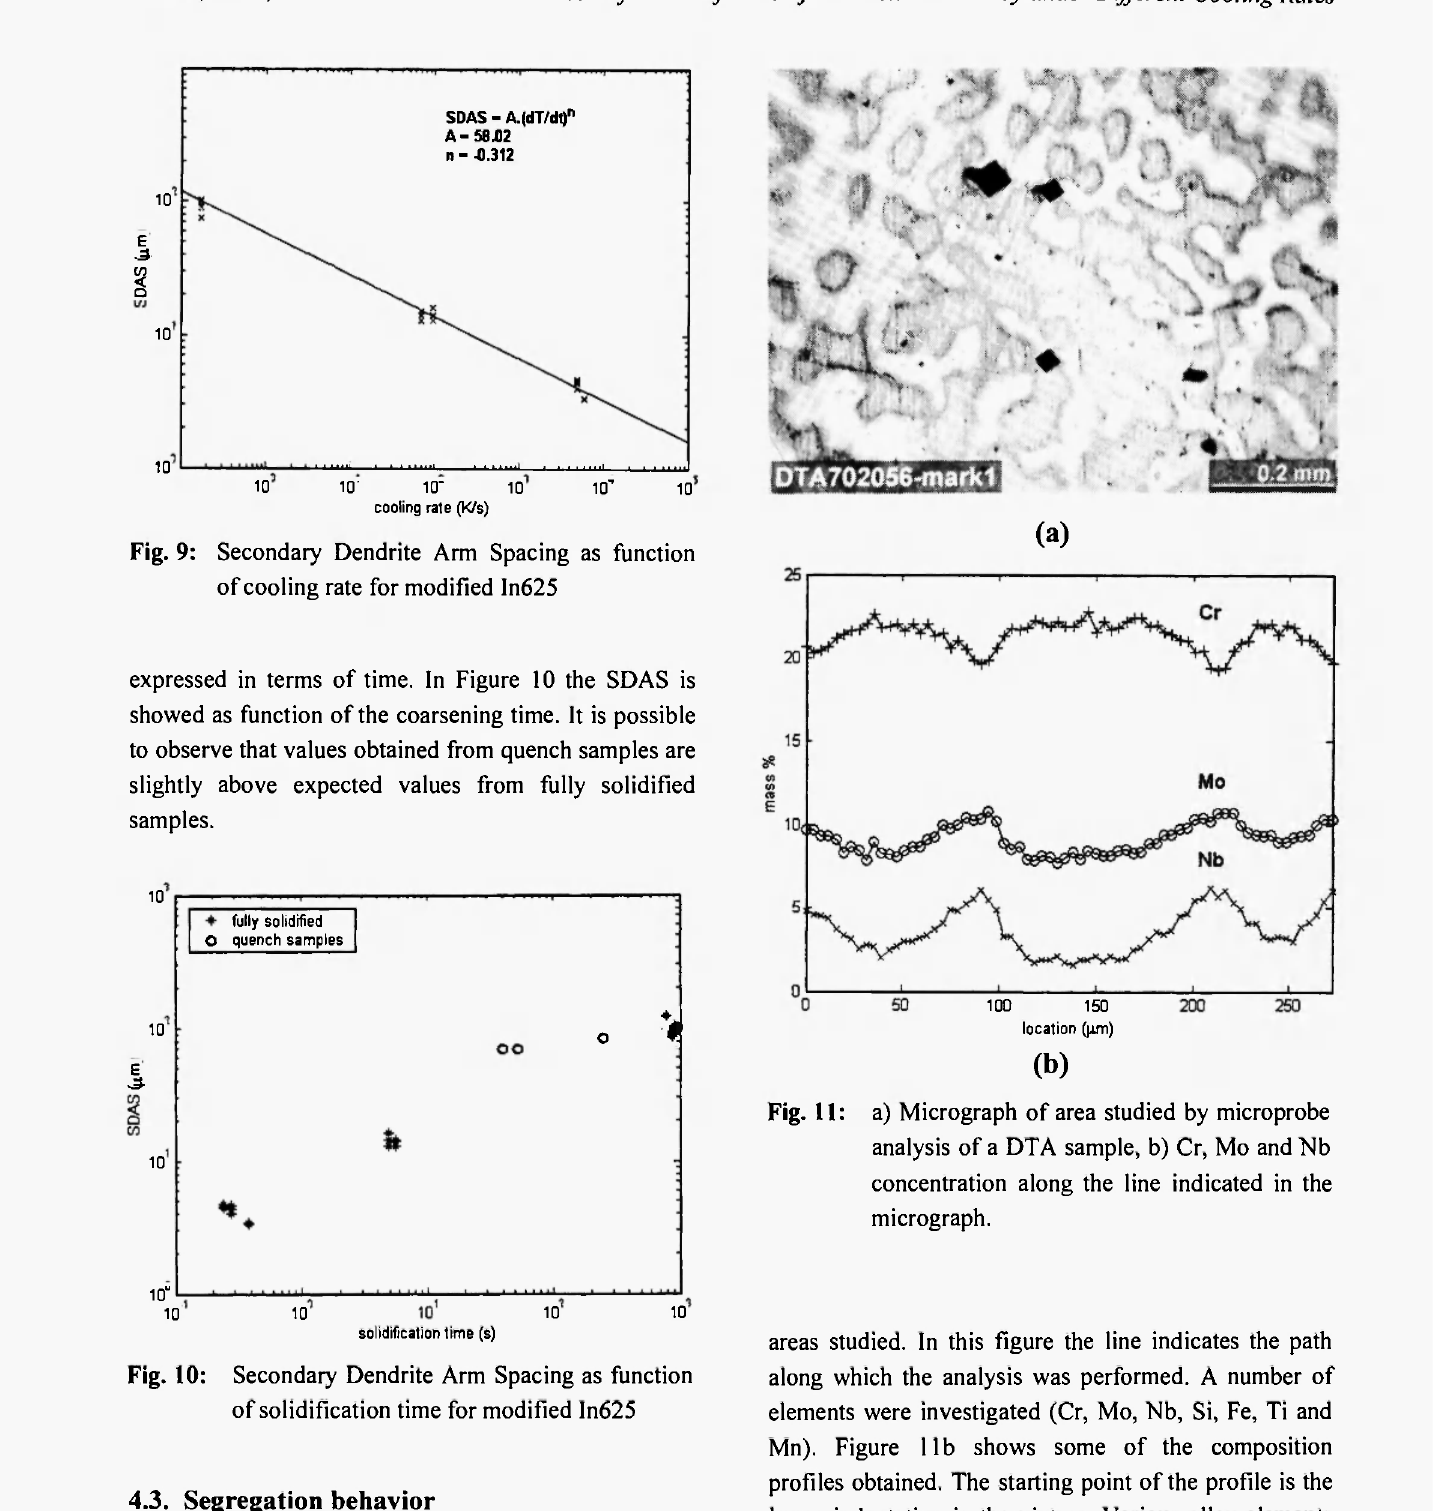
areas studied. In this figure the line indicates the path Fig. 10: Secondary Dendrite Arm Spacing as function along which the analysis was performed. A number of of solidification time for modified In625 elements were investigated (Cr, Mo, Nb, Si, Fe, Ti and Mn). Figure l ib shows some of the composition profiles obtained. The starting point of the profile is the lower indentation in the picture. Various alloy elements have different partition coefficients and different tendencies to segregate; as it is observed, molybdenum and niobium segregate in a positive manner while chromium segregates inversely, i.e. its content in